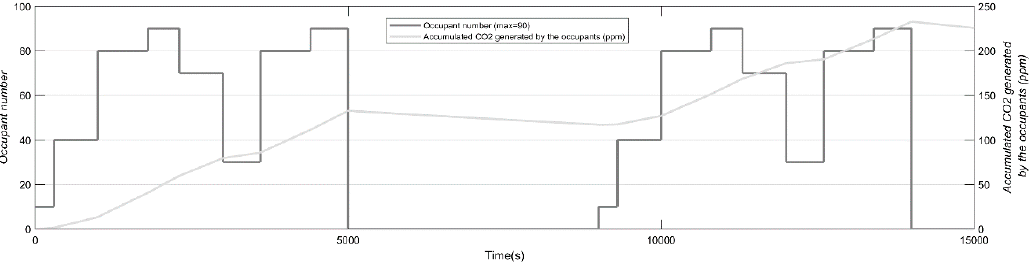
Figure 2. Generated indoor CO2 concentration used as the forecast input for the MPC and GPC.